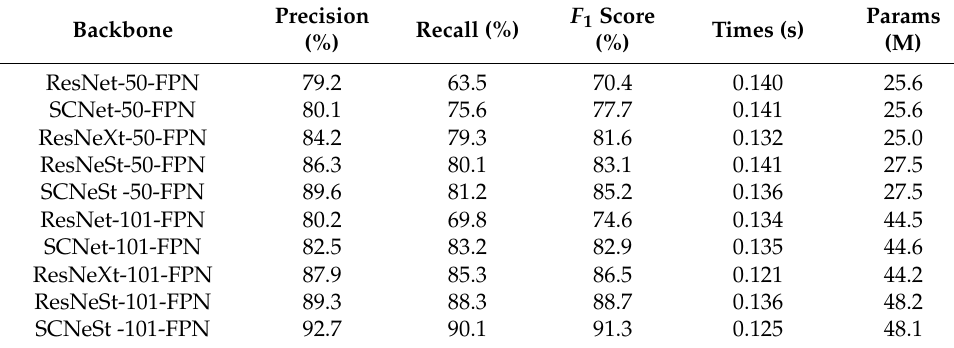
Table 2. Detection index results for different networks. Backbone